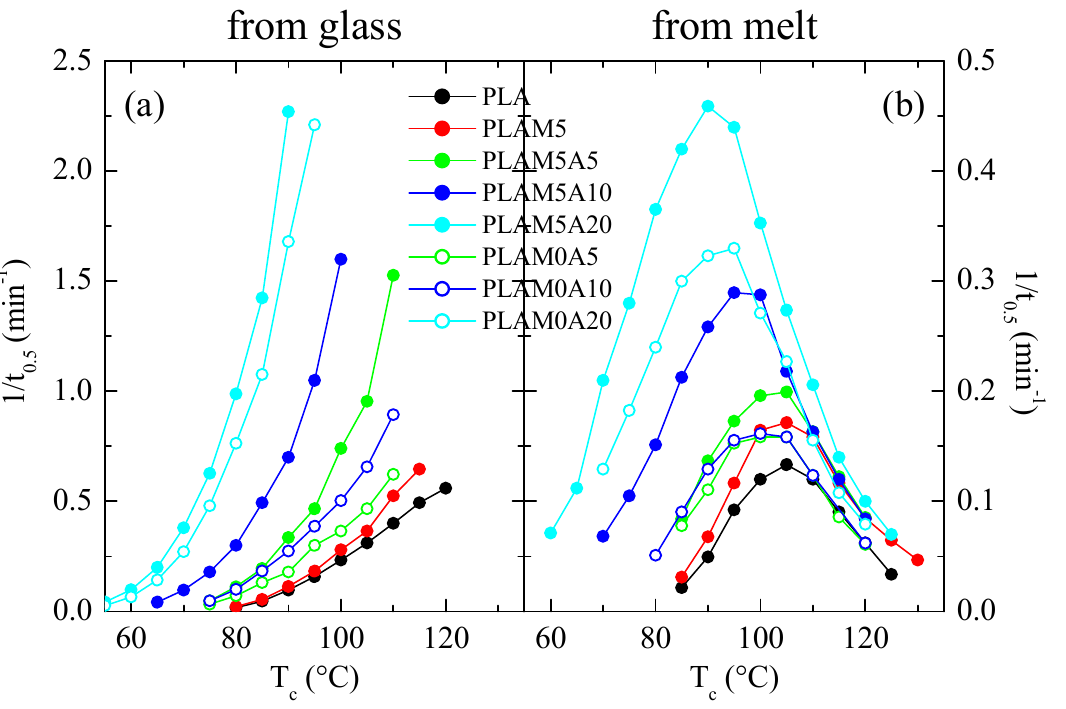
Figure 7. Variation with T c of the inverse of the half crystallization time in the isotherms for the different samples, for isothermal crystallization: ( a ) from the glass and ( b ) from the melt. Note that the Y scale in the data from melt has been amplified 5 times.